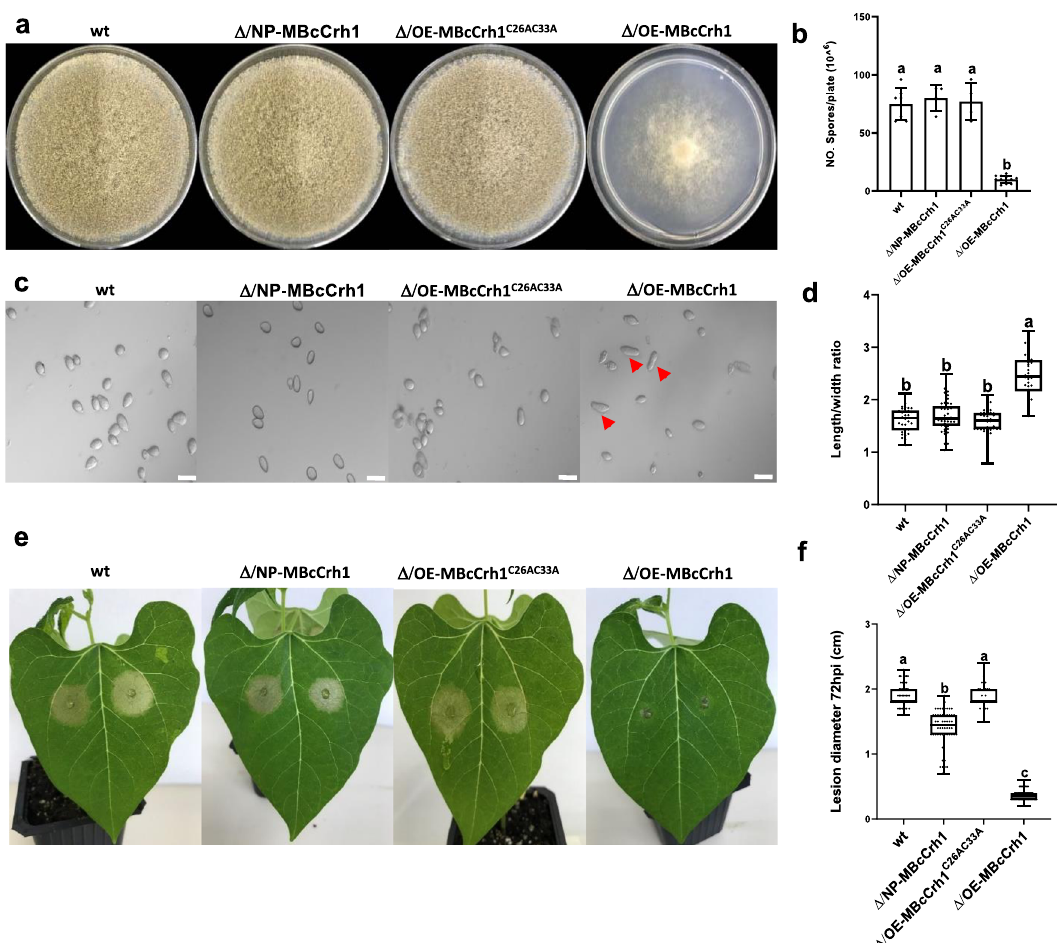
Fig. 7 The pathogenicity and developmental defects induced by MBcCrh1 depend on expression levels. The following strains were characterized: B. cinerea wild type (wt), enzyme inactive BcCrh1 with the native promoter in the background of bccrh1 deletion ( Δ /NP-MBcCrh1), overexpression of MBcCrh1 with mutation of C26 and C33 in a background of bccrh1 deletion ( Δ /OE-MBcCrh1 C26AC33A ), and overexpression of MBcCrh1 in a background of bccrh1 deletion ( Δ /OE-MBcCrh1). a – d Spore production and shape. Fungi were cultured on solid GB5-Glucose medium and grown at 20°C with continuous light. Pictures of plates ( a ) and spores ( c ) were taken after eight days of incubation. Spores were harvested and average spore numbers ( b ) and spore dimensions ( d ) were determined. Arrows indicate spores of the Δ /OE-MBcCrh1 strain with abnormal morphology. For spore numbers, data represent mean ± SD from three independent biological replications. For spore dimensions, the ratio of length/width was calculated. Data of at least 30 spores from three independent biological replications were used for statistical analysis. e – f Bean leaves were inoculated with spore suspensions of the different strains, pictures were taken and lesion size recorded 72 hpi. At least 32 sample data from three independent biological replications were used for statistical analysis. In boxplots ( d and f ), center lines represent the medians, box edges show the 25th and 75th percentiles; whiskers extend to minimum and maximum values from the 25th and 75th percentiles; all present data are indicated as black dots. Different letters in d and f indicate statistical differences at P ≤ 0.01 according to one-way